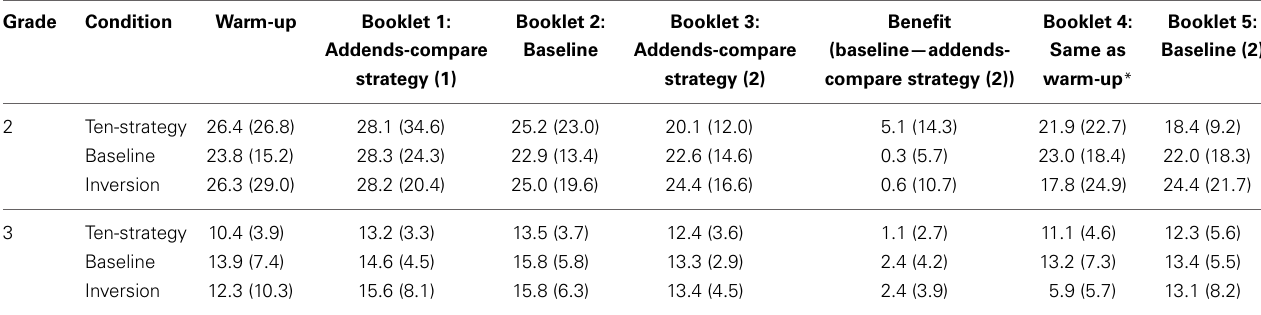
Table 3 | Mean time per problem and standard deviation analyzed for booklet type and grade in Experiment